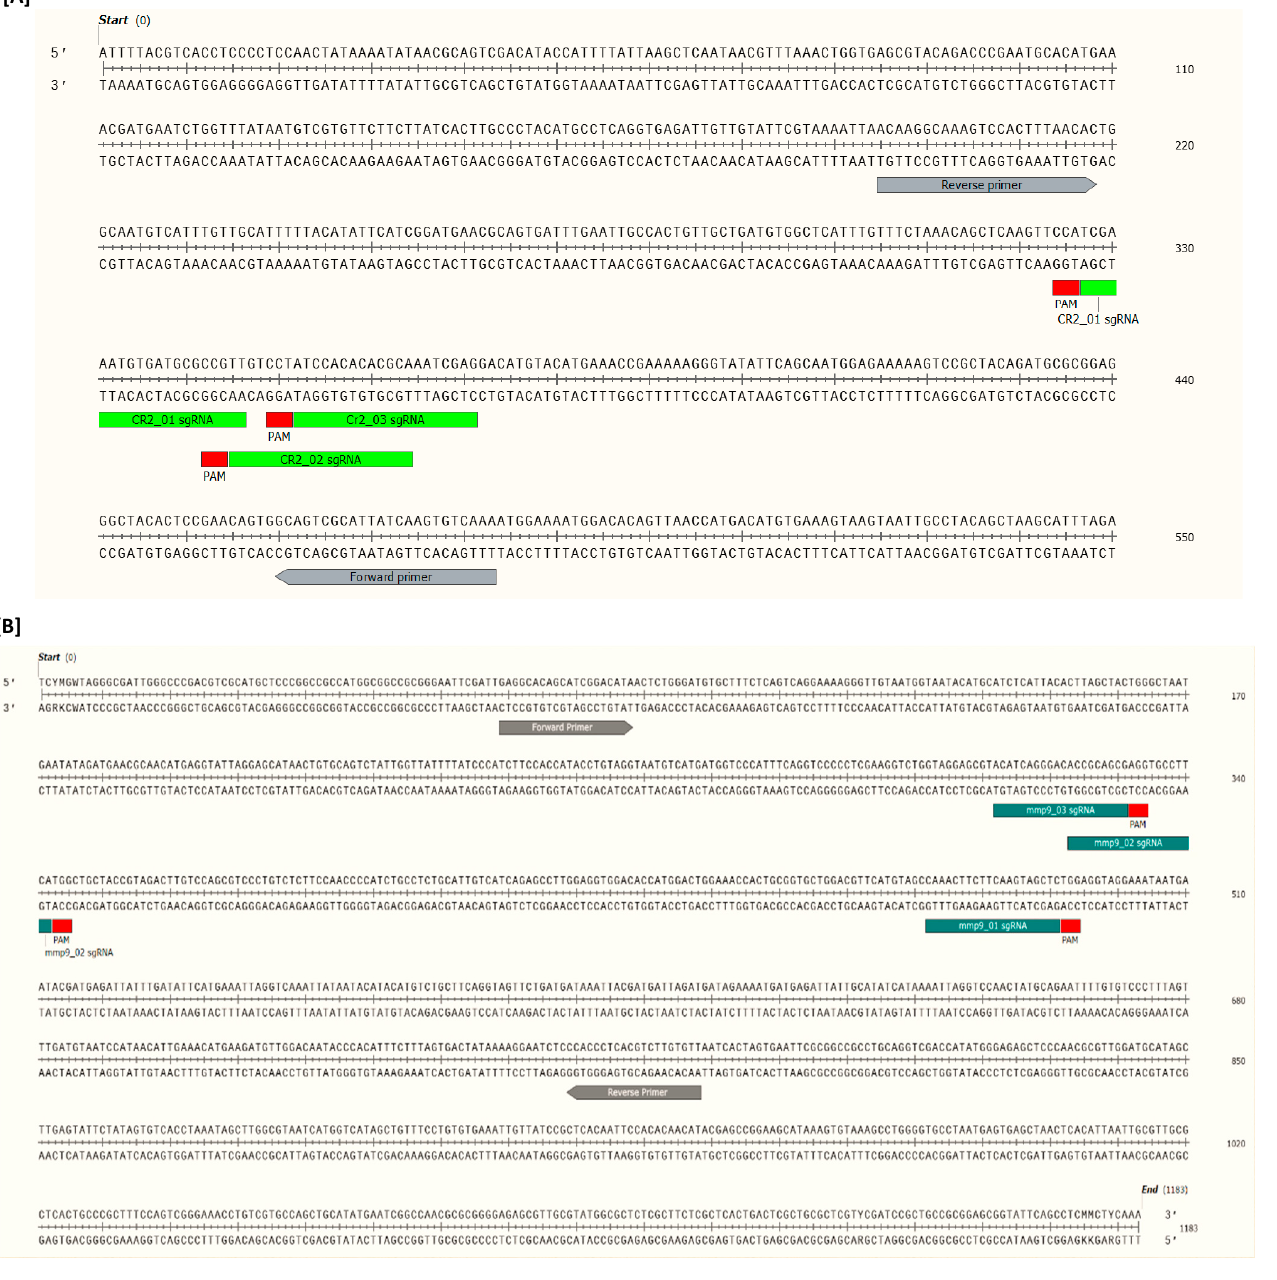
Figure 5. Targeted regions of interest for ( A ) cr2 and ( B ) mmp9 indicated by their respective sgRNAs and flanked by primers used in amplifying these regions.